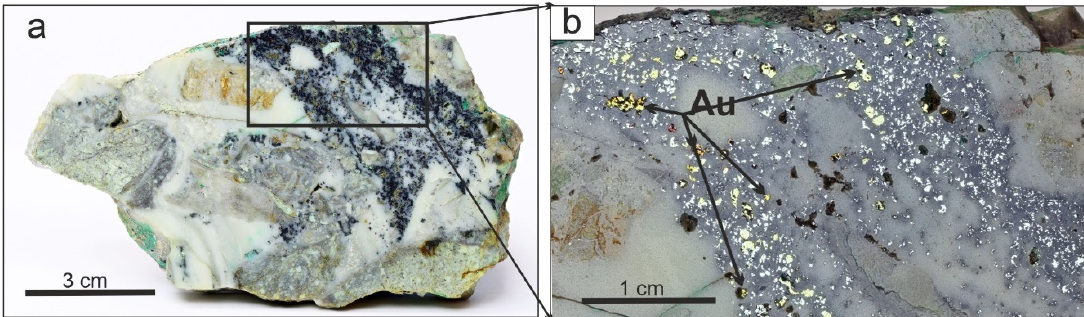
Figure 4. Sample of sericite-adularia-quartz composition with crustified-breccia texture containing disseminated sulfide and sulfosalts ( a ) and visible gold on an enlarged fragment of the sample ( b ) (sample Bar_2-1, Rusty zone).